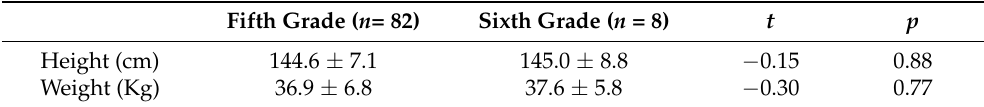
Table 1. Participants’ height and